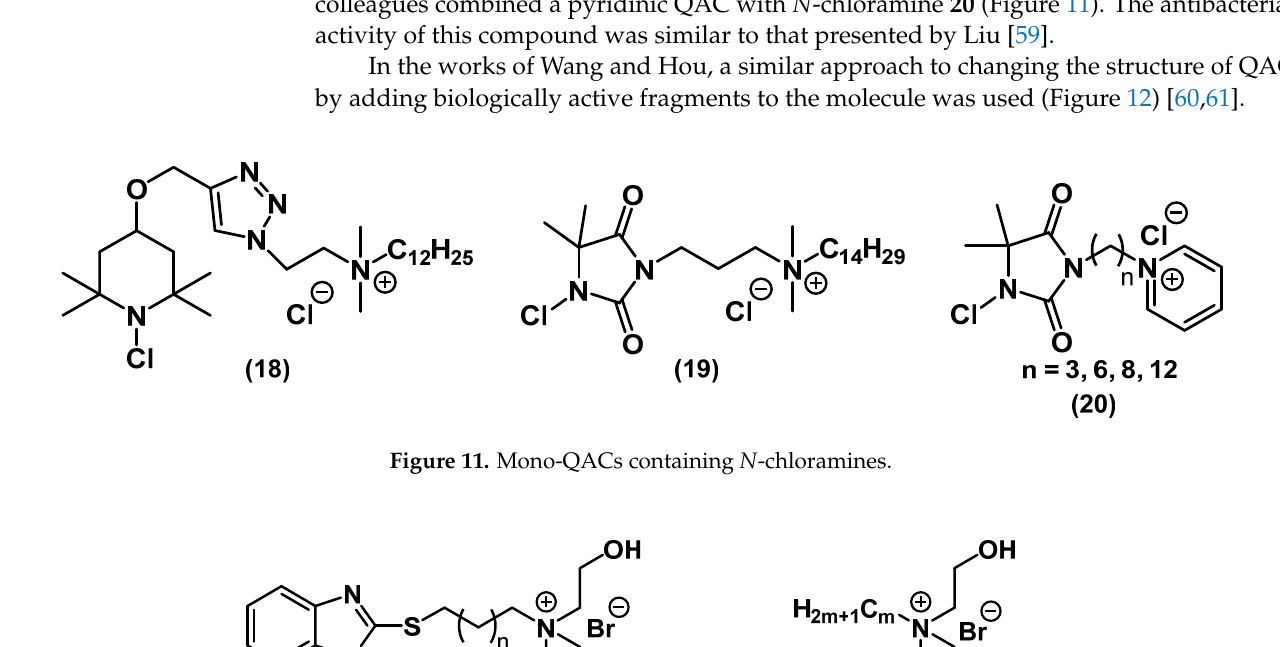
Figure 11. Mono-QACs containing N -chloramines.